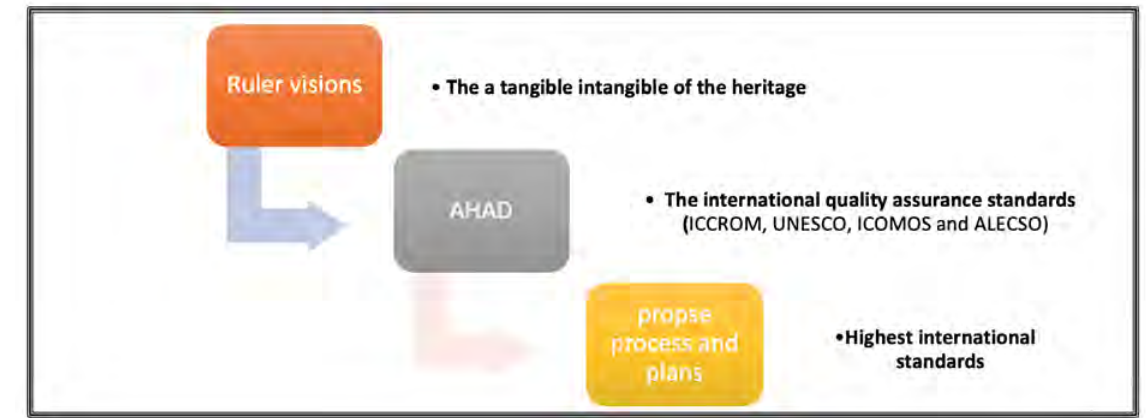
Figure 4. The process to approach the international standards for Renovation a Historical District